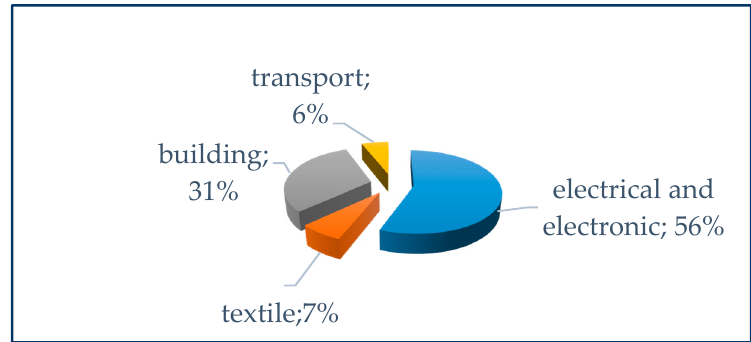
Figure 5. Greater fields of use of brominated flame retardants (BFRs) (Source data: [135]).